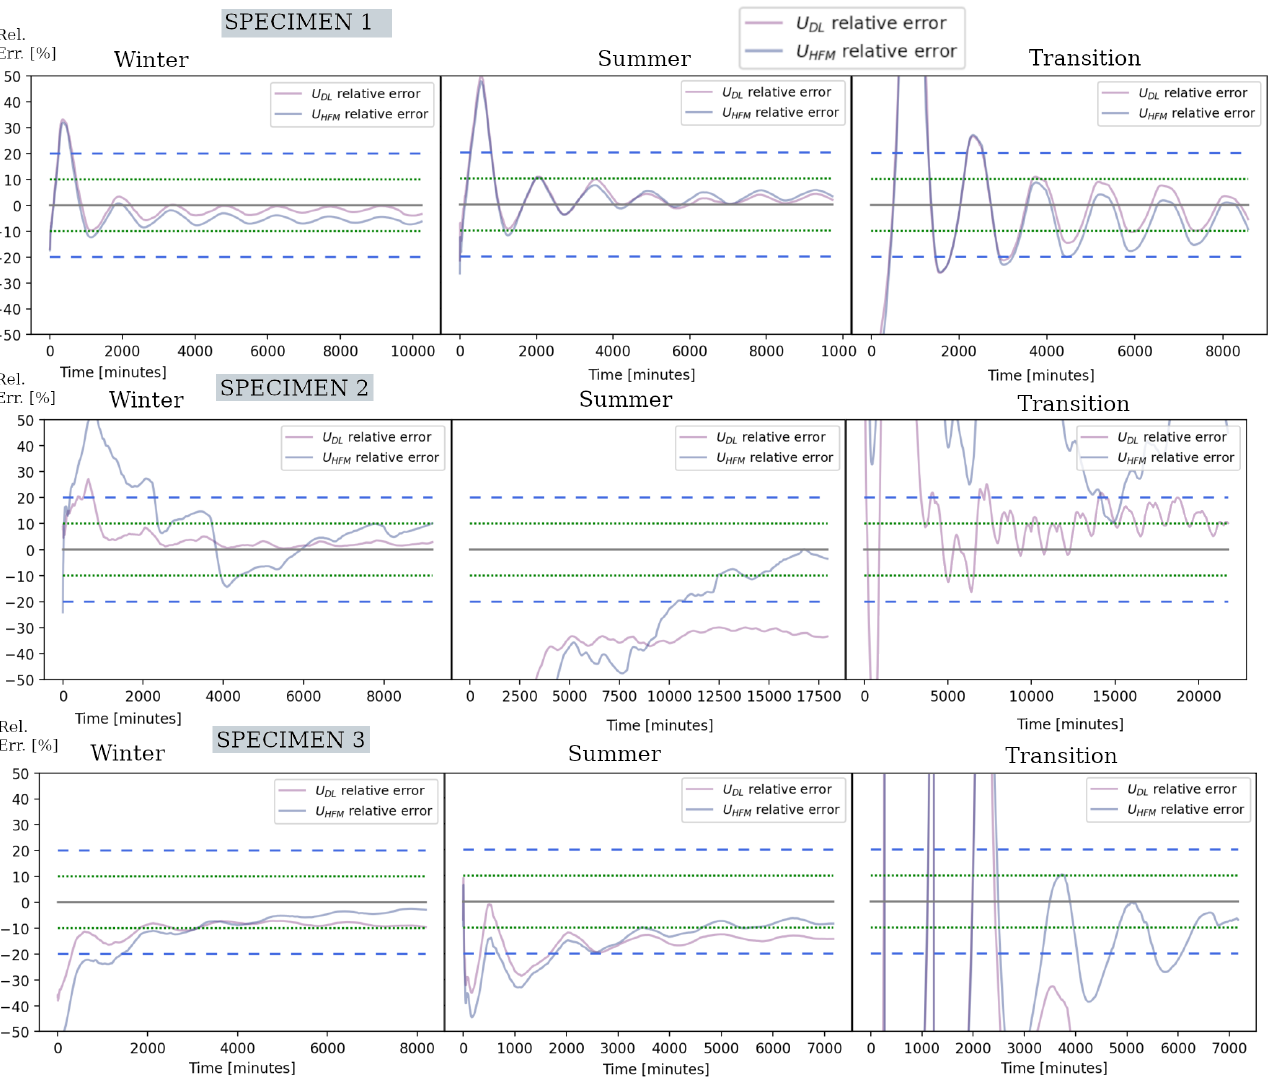
Figure 9. U -value relative error throughout the measurement compared to the ISO 6946 U -value (predicted vs. measured